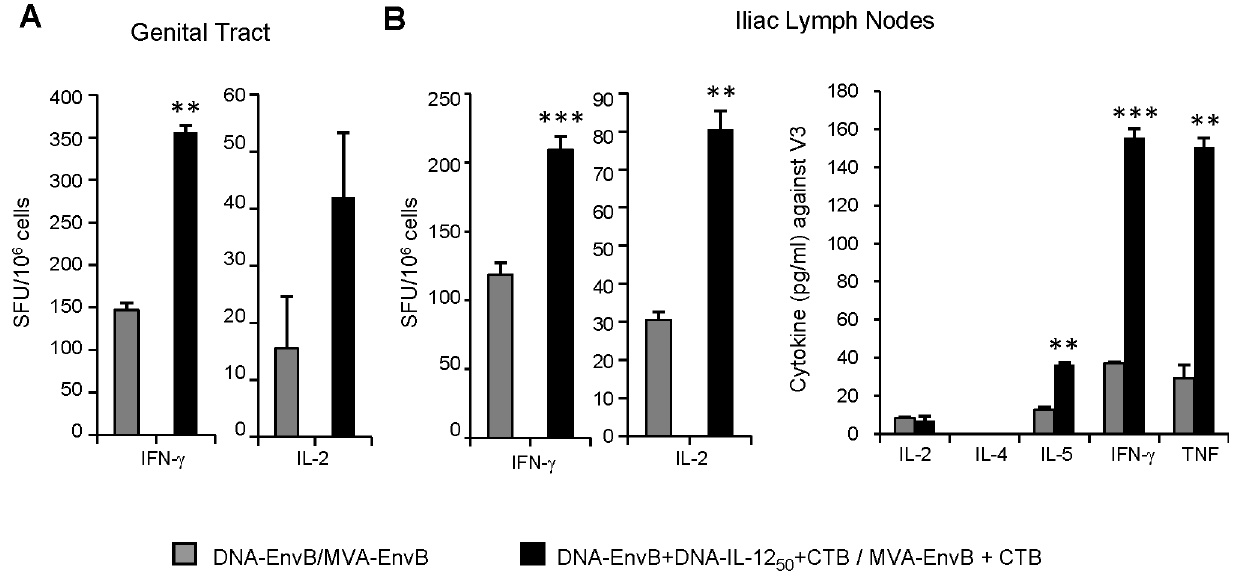
Figure 2. Nasal co-administration of IL-12 plus CTB improved the quality of the mucosal specific cellular immune responses in the genital tract. Groups of six BALB/c mice were immunized following the control: (DNA-EnvB/MVA-EnvB: grey bars) and IL-12 50 + CTB (DNA-EnvB + DNA- IL-12 + CTB/MVA-EnvB + CTB: black bars) immunization schemes described in Table 1. Ten days after the MVA booster dose specific cellular immune responses against Env peptide were quantified by ELISPOT assay (IFN- c and IL-2 secreting CD8 + T-cells) in (A) genital tract and (B) iliac lymph nodes (ILNs, left panel). Data are representative of three independent experiments with comparable results. (B, right panel) Iliac lymph-node (ILNs) cells were stimulated with specific peptide during 72 h and cytokines were measured in culture supernatants using the mouse Th1/Th2 cytokine cytometric bead array (CBA). Bars represent the average values + SD of duplicate determinations from pooled samples. Background values of negative control (RPMIc) were subtracted. Responses were considered as positives if they were above the cut-off values (RPMI + 3SD). Statistical differences between groups: **p , 0.01; ***p , 0.001 by Student’s T test.